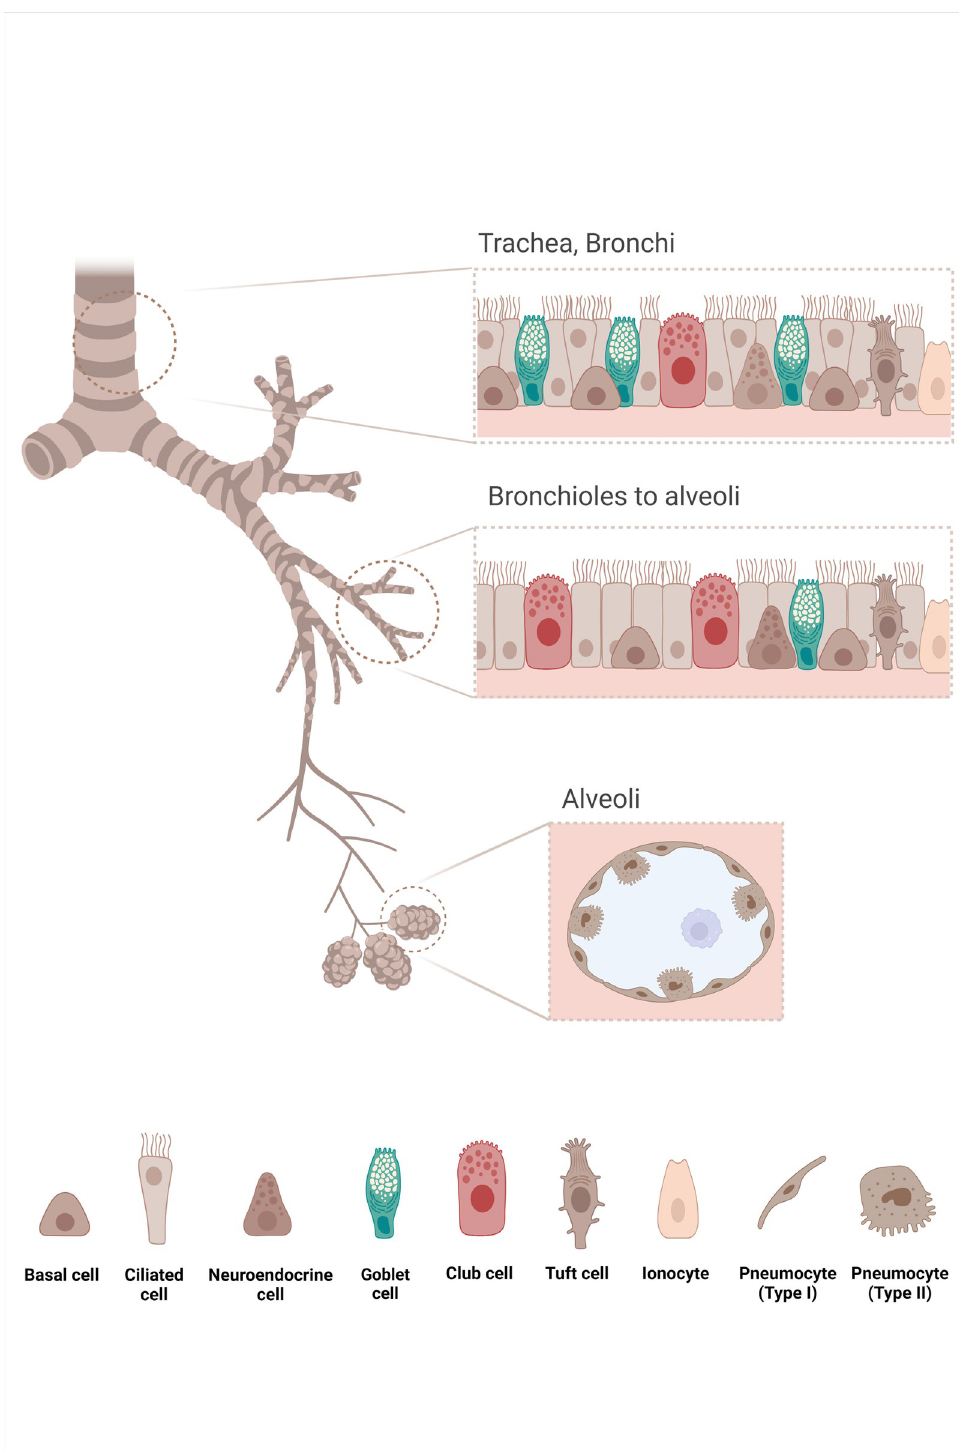
Fig 1. Lung epithelia structure. The lung is a complex organ composed of conducting airways and gas exchange zones. The conducting airways branch from the trachea to terminal bronchioles that end up in the alveoli. In airways, the lining epithelium provides a physical barrier between the external environment and the underlying parenchyma, whose integrity is maintained by intercellular junctions. The airway epithelium ensures the protection of the lung against inhaled particles, toxins, and pathogens through the mucociliary clearance and secretion of molecules with antibacterial,